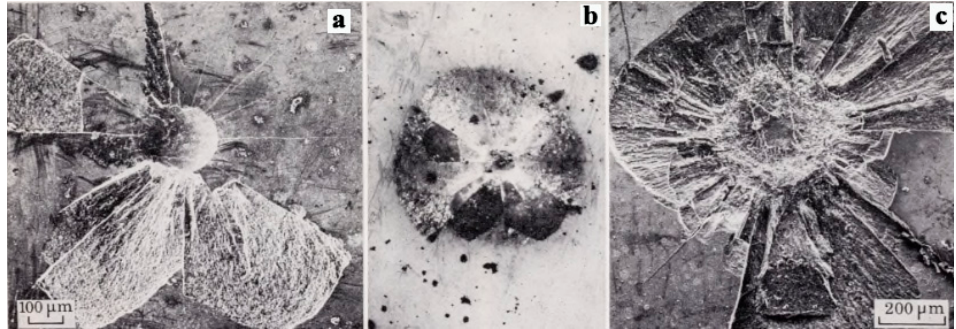
Figure 13. Common impact deformation patterns noticed in the brittle material as a plastic reaction regime, where ( a ) shows the radial cracking that generated from the central impression and material